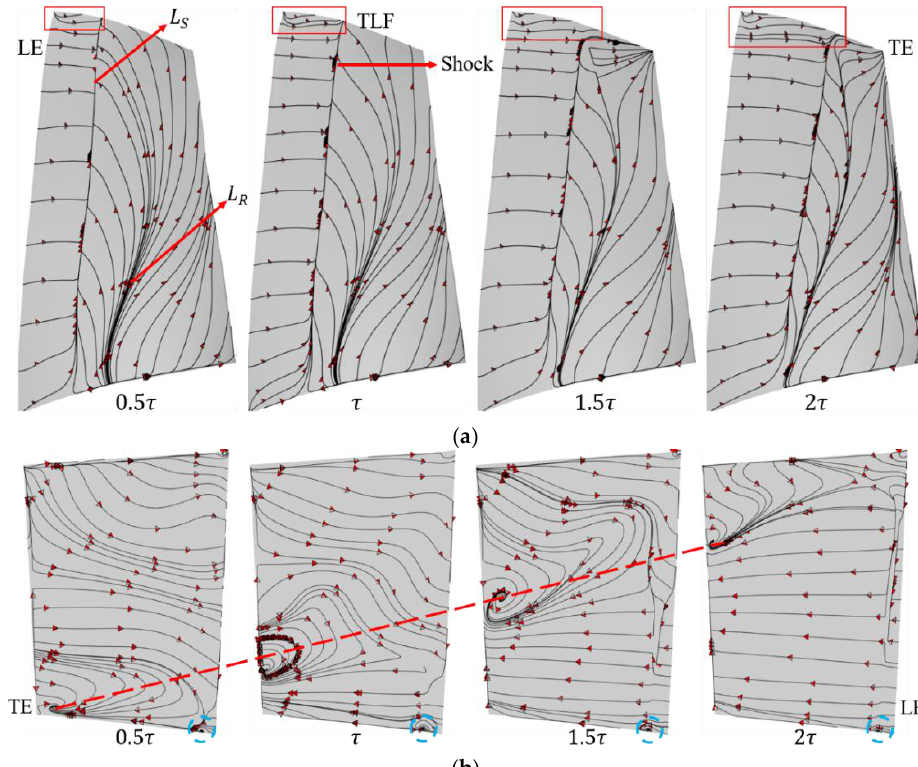
Figure 18. Blade suction surface streamlines at the near stall point: ( a ) Rotor ; ( b ) Stator .